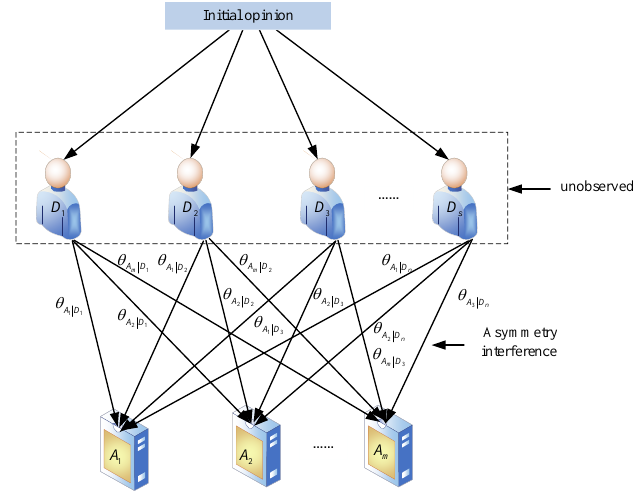
Figure 5. Asymmetric interference effects among decision-makers.